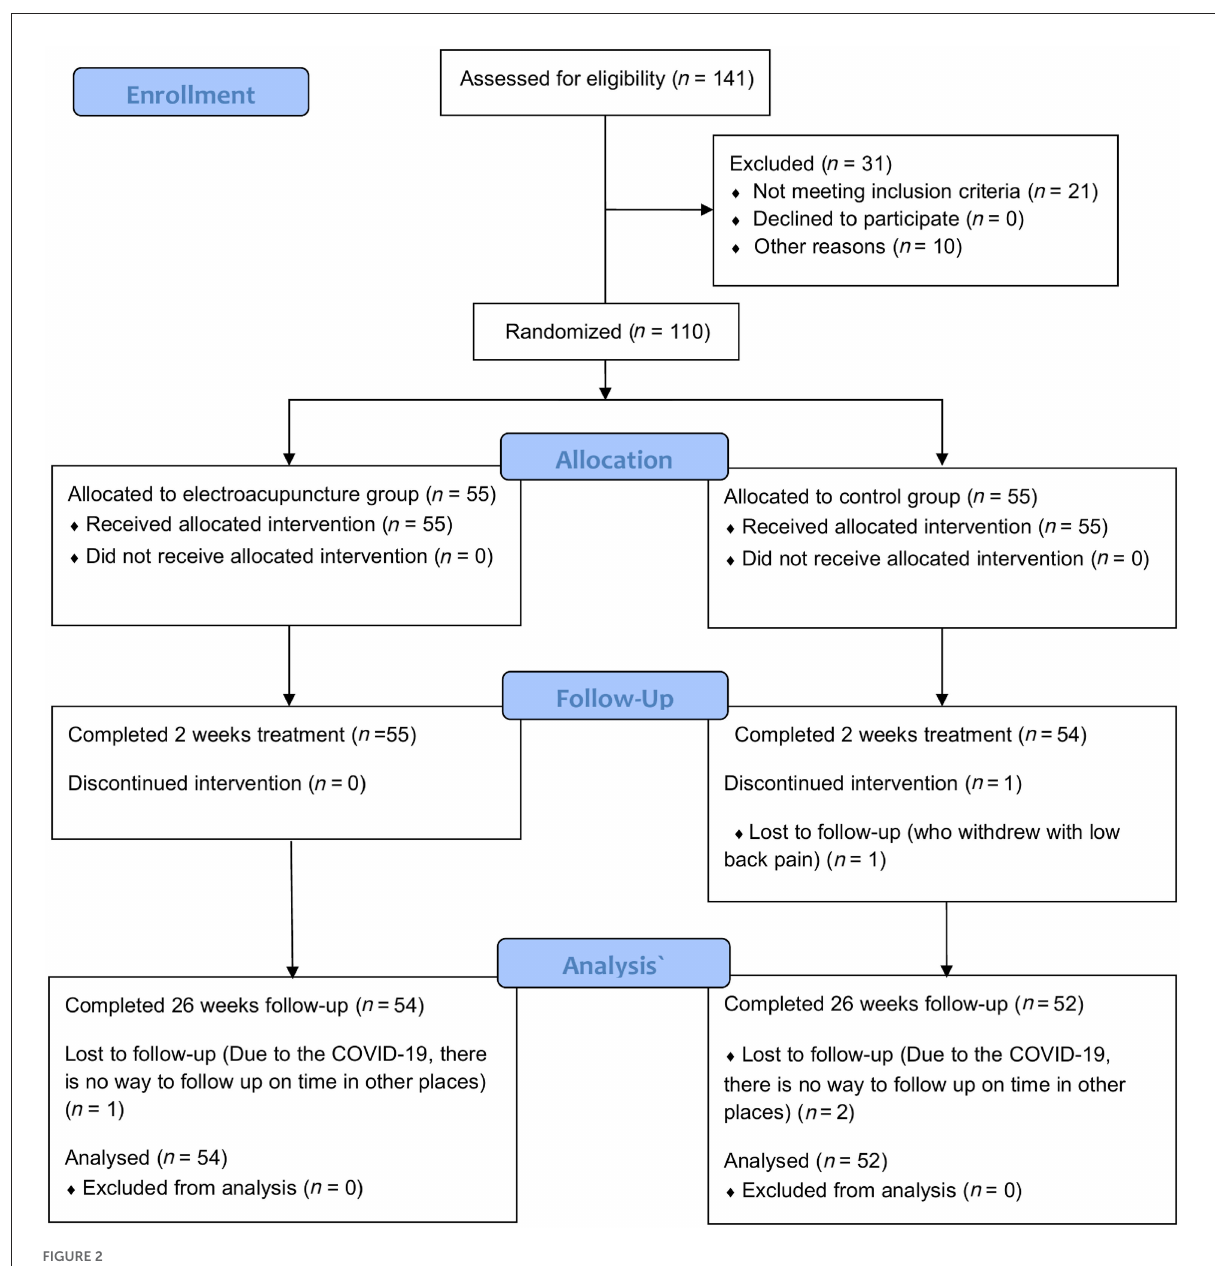
FIGURE2 Study flow diagram of participants through the study period.